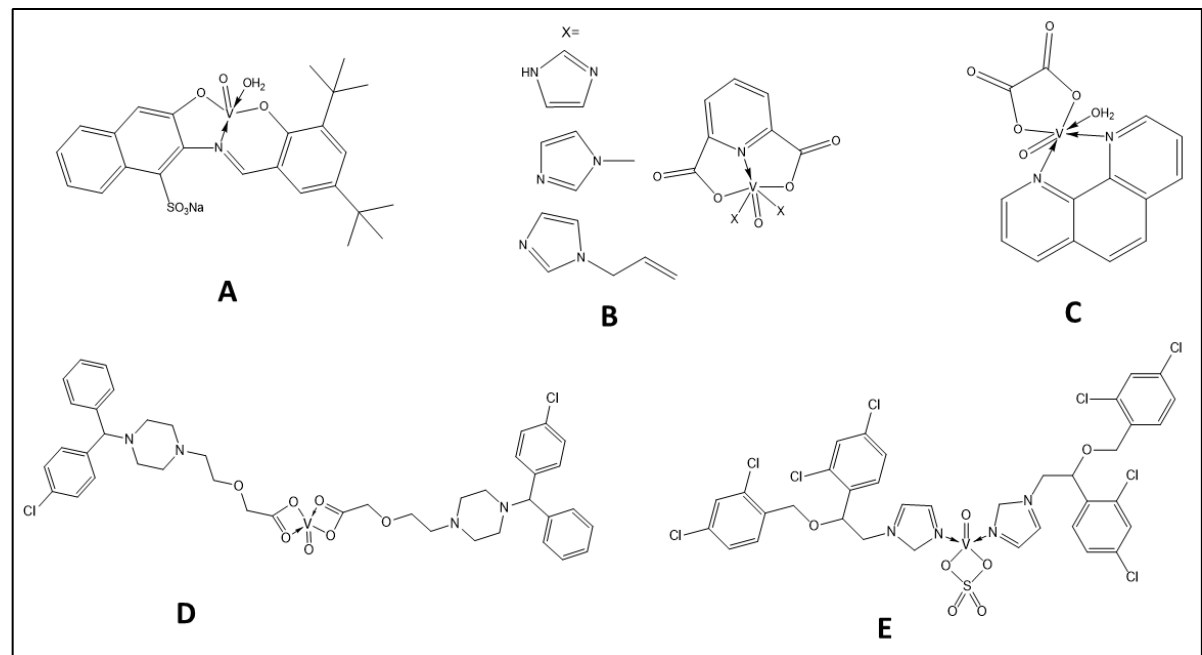
Figure 5. The structure of some vanadium complexes with anticancer activity.